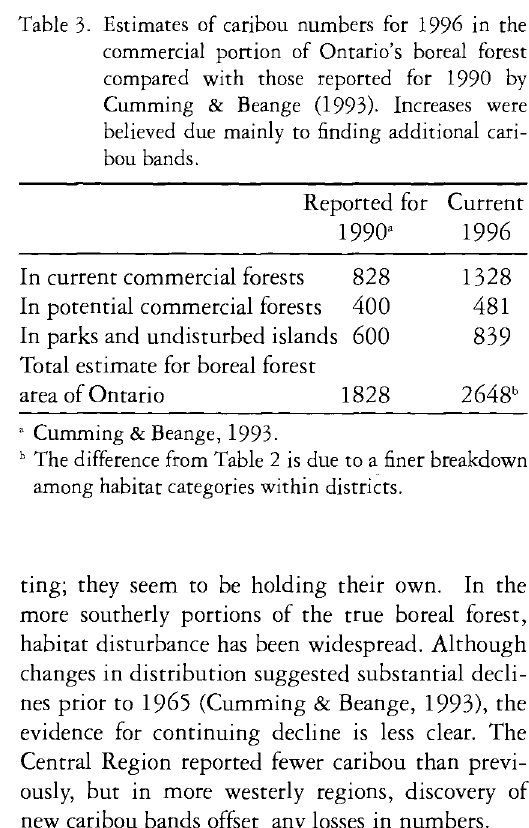
Table 3. Estimates of caribou numbers for 1996 in the commercial portion of Ontario's boreal forest compared with those reported for 1990 by Cumming & Beange (1993). Increases